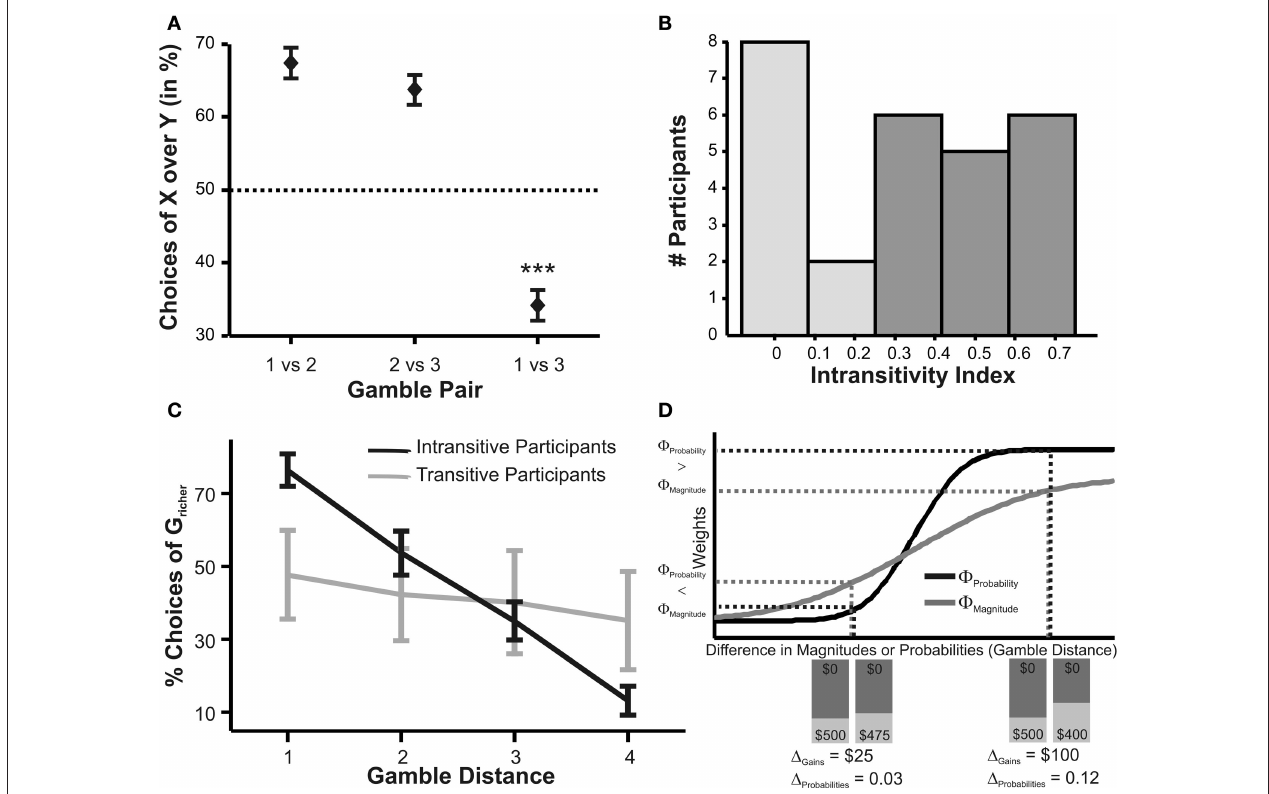
G over G , but preference reversed with higher gamble-distances richer safer ( p < 0.0001). Preference for G or G was less distance-dependent in richer safer transitive subjects. (D) Sigmoidal weighting-functions can explain the context-dependent shift from preferring richer to safer gambles (cf. C ). The weighting functions for probabilities ( Φ , black line) and magnitudes Probability ( Φ , gray line) cross because of their presumed different shapes. As a Magnitude consequence, Φ is higher than Φ when the difference in Magnitude Probability magnitudes and probabilities is minute, e.g., at a small gamble-distance (cf. left gamble pair). However, when the difference in both attributes increases (greater gamble-distance, right gamble pair), the weights reverse and Φ is larger Probability than Φ . Accordingly, at gamble-distance 1 (illustrated by the left gamble Magnitude pair in Figure 2D ), decisions should be more strongly influenced by magnitudes than by probabilities, and individuals should have a higher propensity to choose the gamble with the higher magnitude (G ). Conversely, at higher distances richer (e.g., the right gamble pair), decisions should be more strongly influenced by ) in intransitive (black richer probabilities than by magnitudes, and individuals should be more likely to choose the gamble with the higher probability (G safer